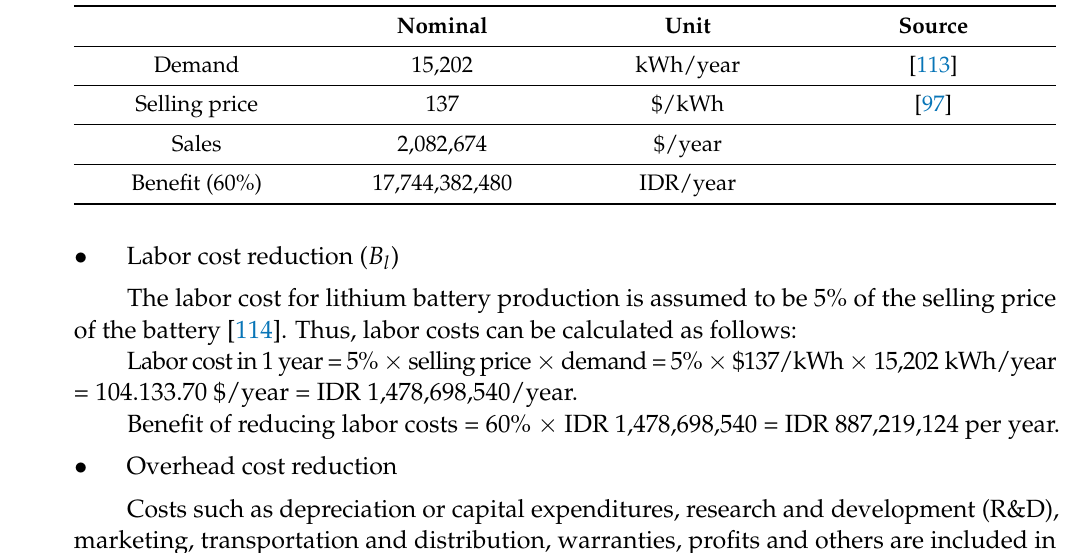
Table 10. Calculation of the increase in sales.